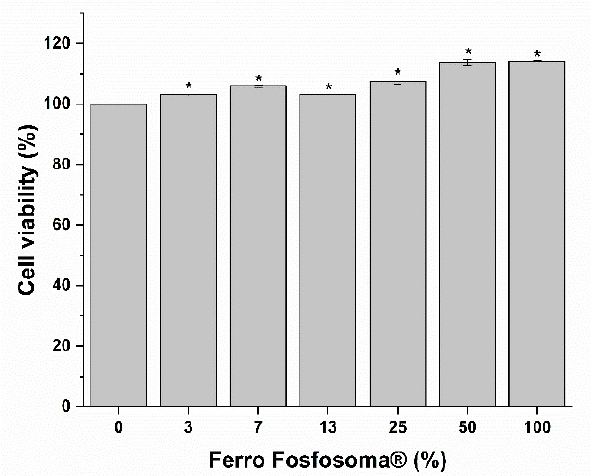
Figure 3. Effect on cell viability of human intestinal follicle-associated epithelium (FAE) monolayer. FAE monolayer was exposed to increasing concentrations of the bioaccessibile fractions of the granular form of ferric pyrophosphate for 3 h, and then cell viability was determined using MTS assay. * p < 0.05.